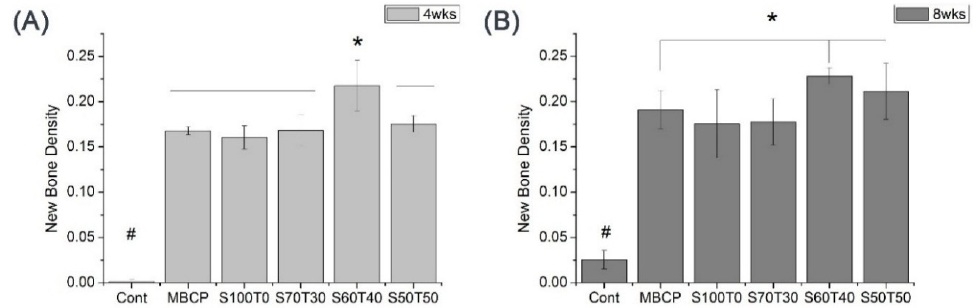
Figure 3. Quantitative results of new bone formation: ( A ) four weeks; and ( B ) eight weeks. * , # means significant differences ( p < 0.05).